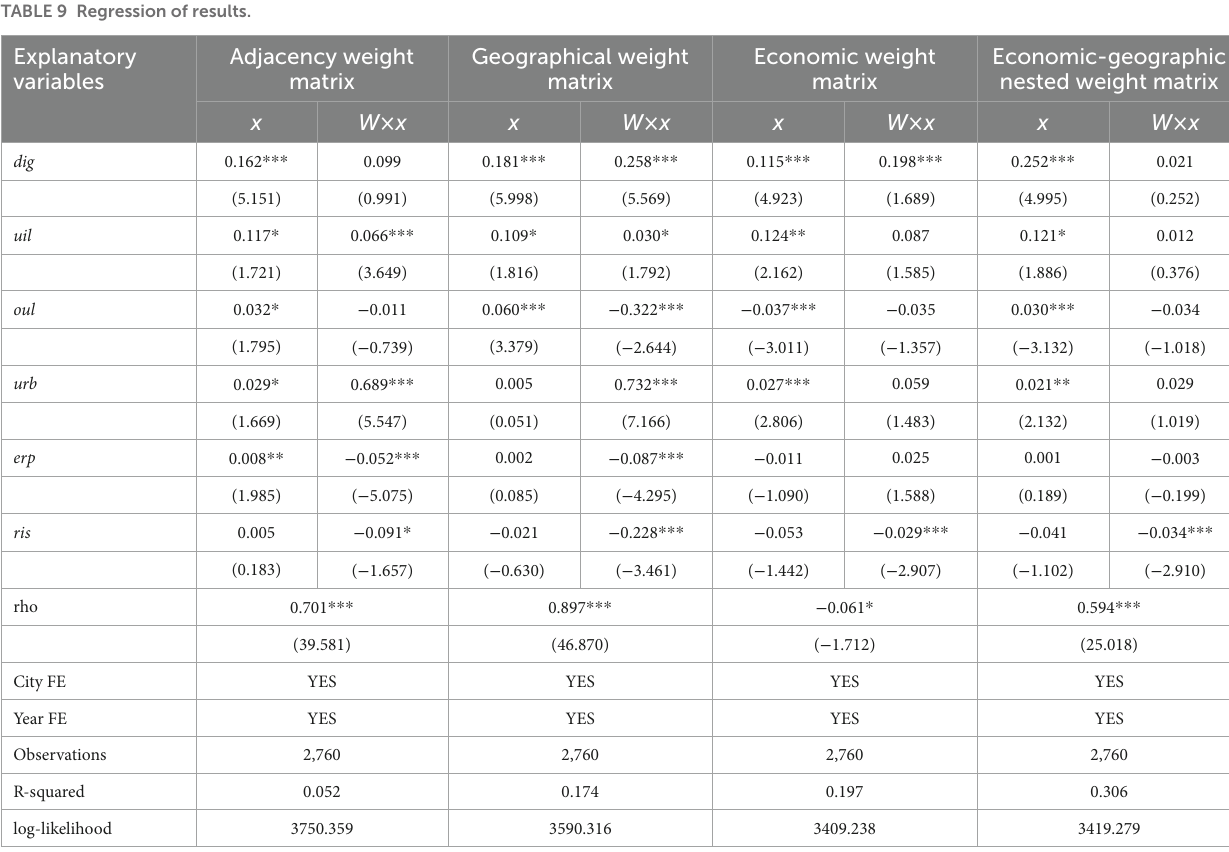
TABLE 9 Regression of